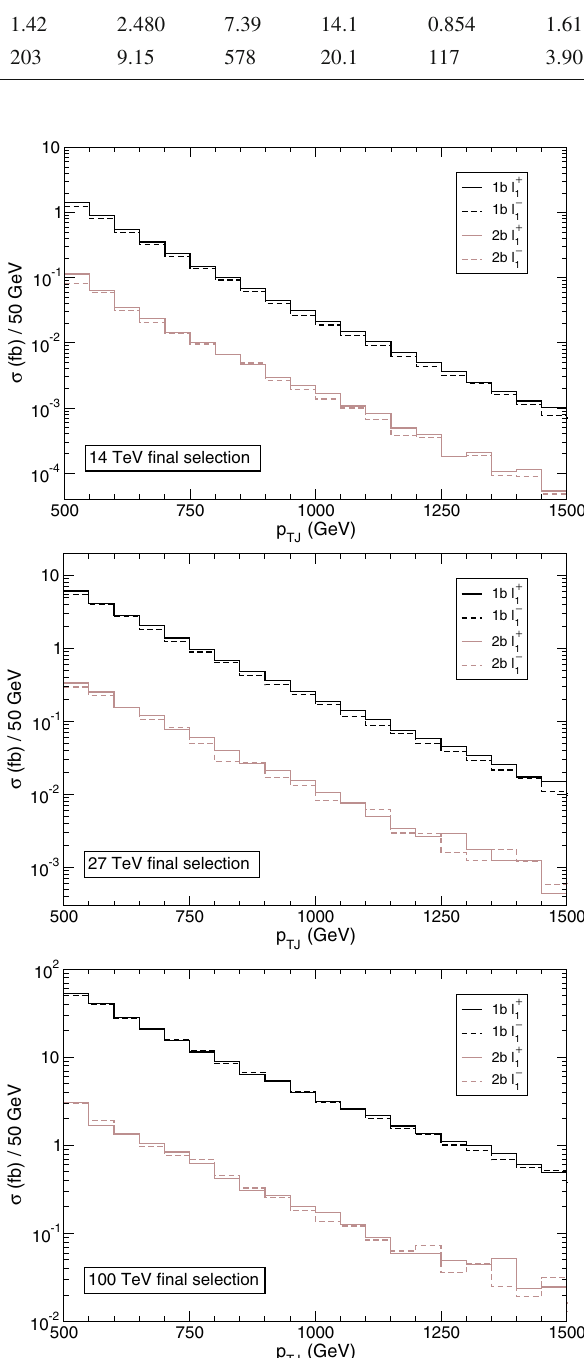
Fig. 8 Signal cross sections for positive and negative charged